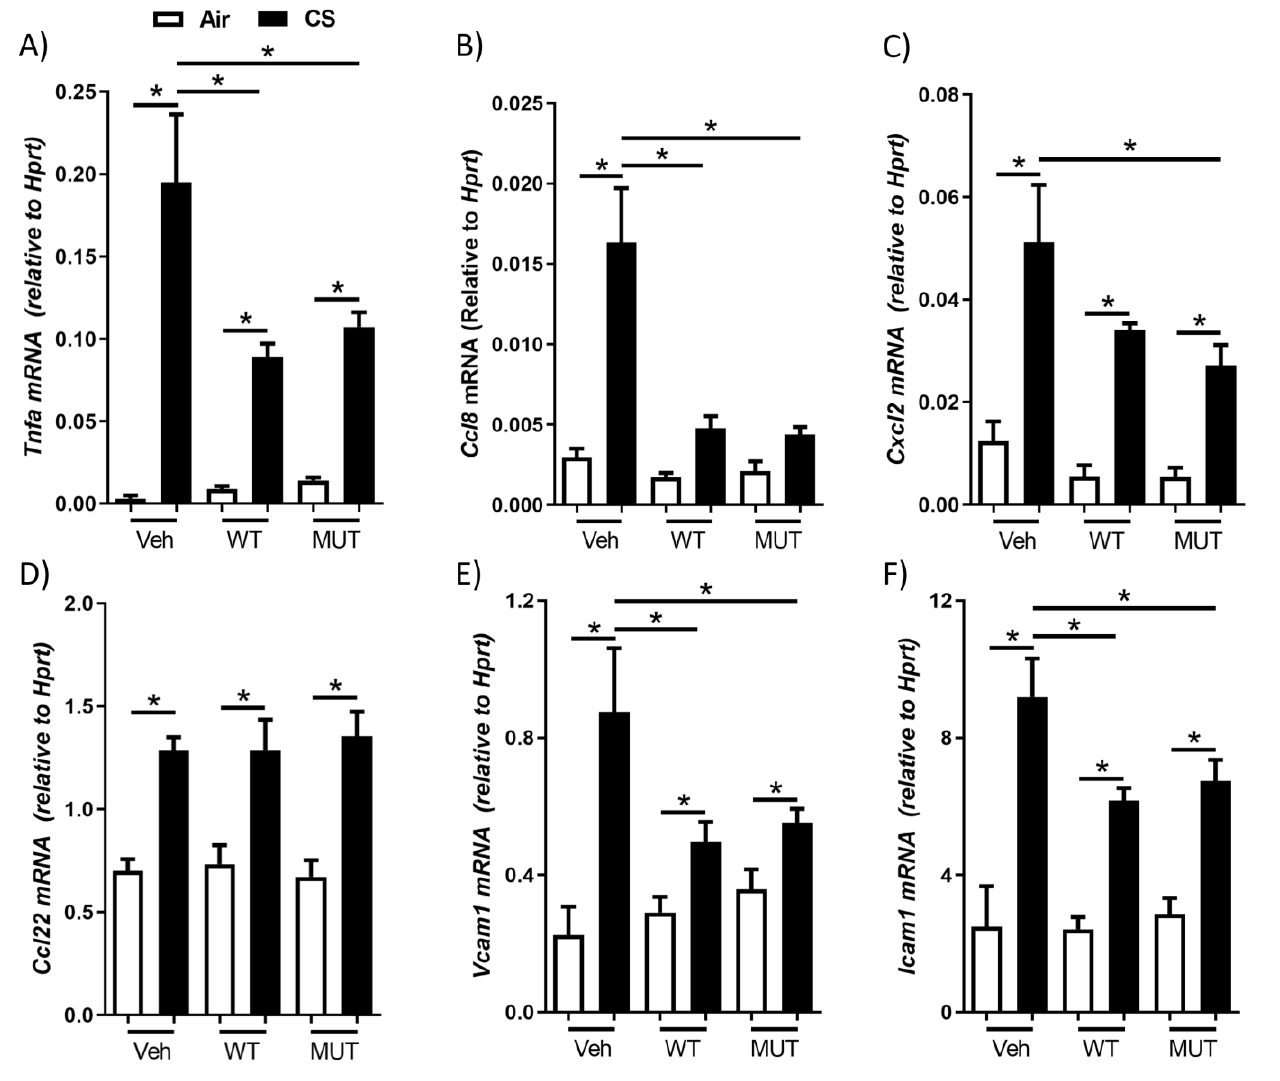
Figure 2. Probiotic Bifidobacterium longum subsp. longum suppressed cigarette smoke-induced cytokine and adhesion factor gene expression. Mice were treated with wild-type (WT) or mutant (MUT) B. longum subsp . longum or vehicle (Veh) by oral gavage and were exposed to cigarette smoke (CS: black) or normal air (Air: white) for 8 weeks. ( A ) Tnfa , ( B ) Ccl8, ( C ) Cxcl2 , ( D ) Ccl22, ( E ) Vcam1, and ( F ) Icam1 gene expression relative to Hprt was assessed by qPCR in lung tissues. Data are presented as mean ± SEM. N = 5 – 6. * = p < 0.05.